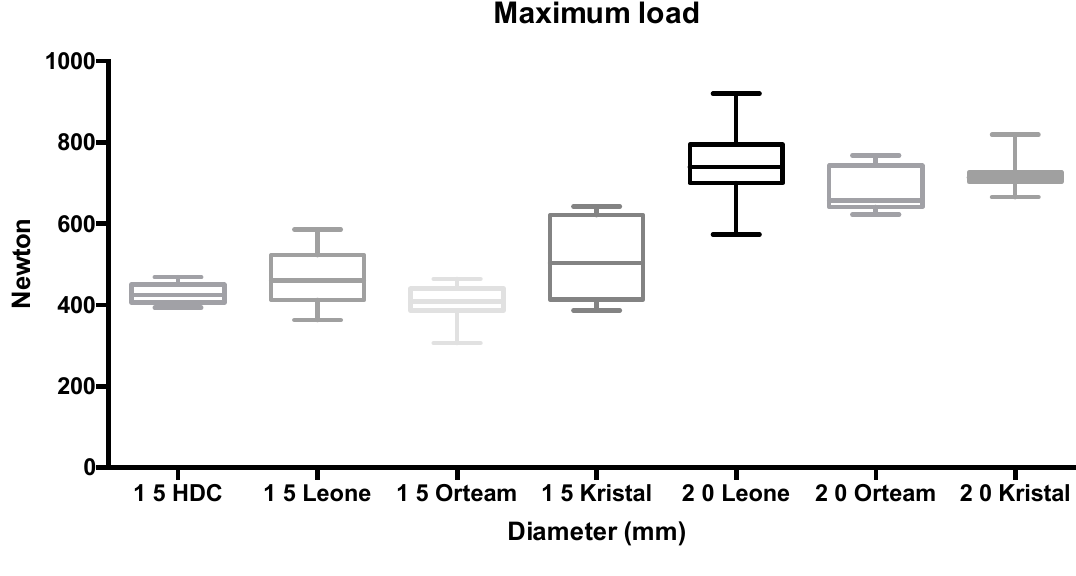
Figure 5. Box plot of groups tested at maximum load before fracture (N).